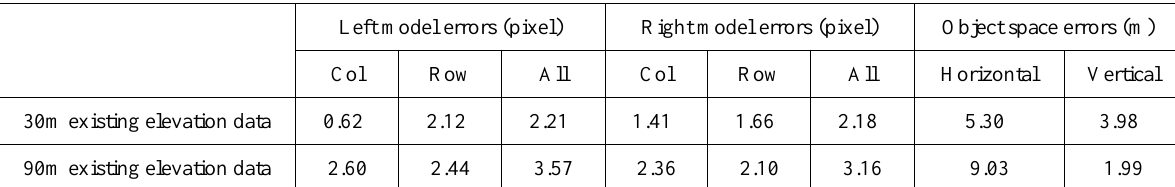
Figure 3. SPOT-5 DEM from automatic DEM Matching Table 3. Automatic DEM matching results using 90m existing global elevation data Left model errors (pixel) Right model errors